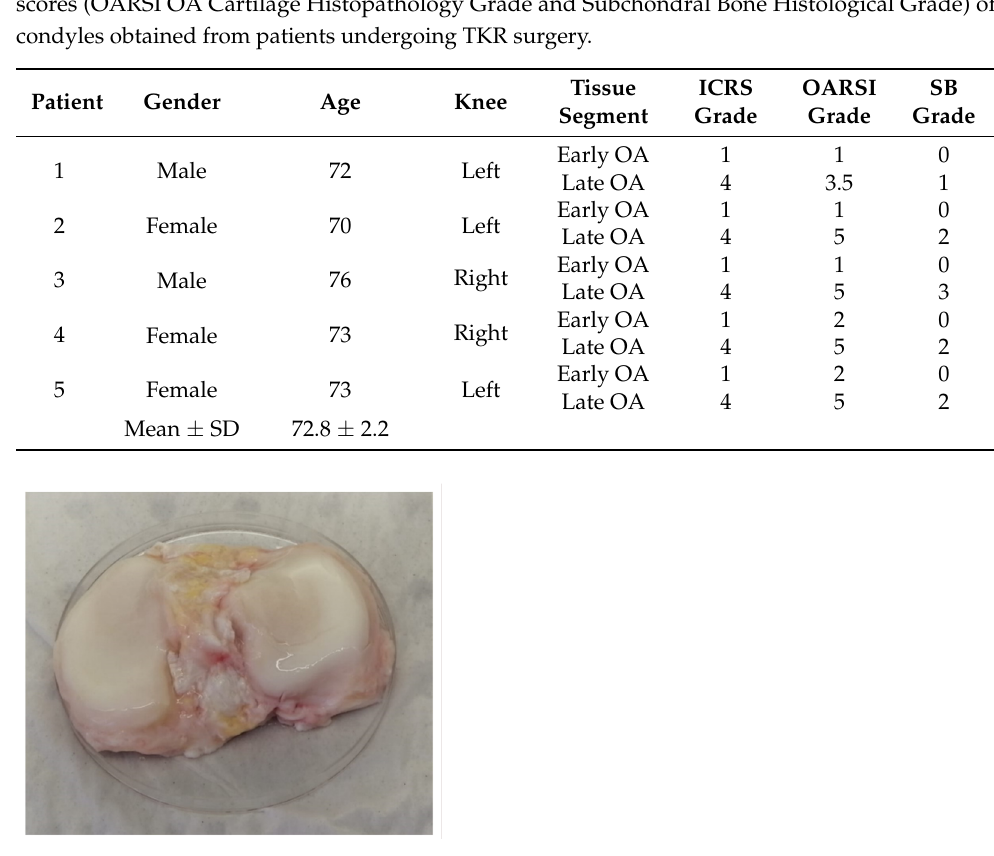
Figure 5. Macroscopic appearance of the tibial plateau obtained from a young patient with no history of OA, sourced from the NHSBT. Right knee from posteroanterior view.